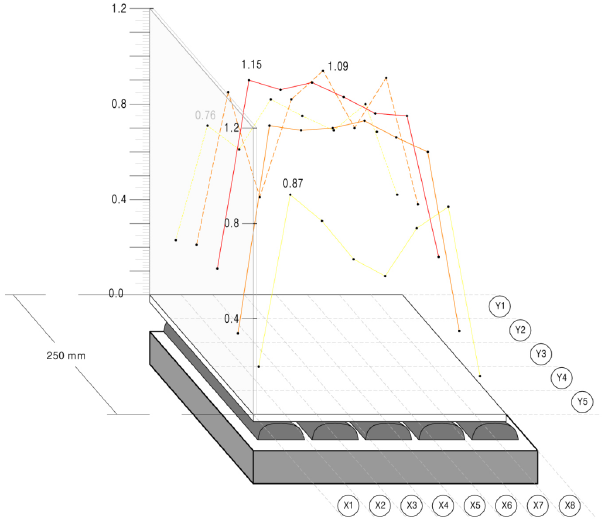
Figure 16. AR 100% specimen adhesion strength per piece coordinate (average).